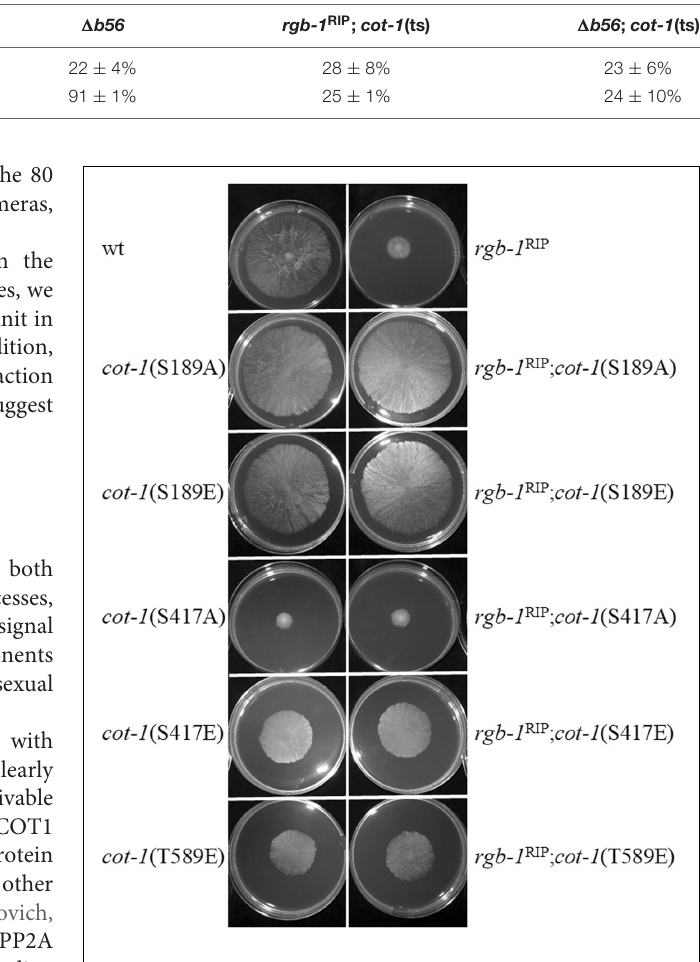
FIGURE 7 | rgb-1 RIP is phenotypically suppressed in several cot-1 phosphomimetic mutant backgrounds. Strains were cultured for 20 h at 34 ◦ C.